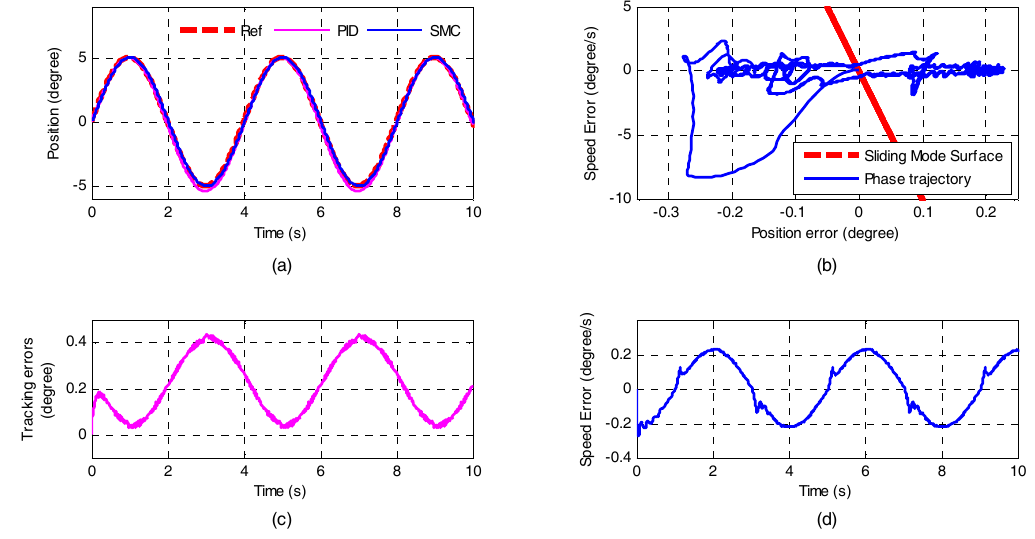
Figure 13. Experiment of sinusoidal response of Joint 2: ( a ) Position tracking; ( b ) Phases trajectory diagram of SMC; ( c ) Tracking error of PID; and ( d ) Tracking error of SMC.